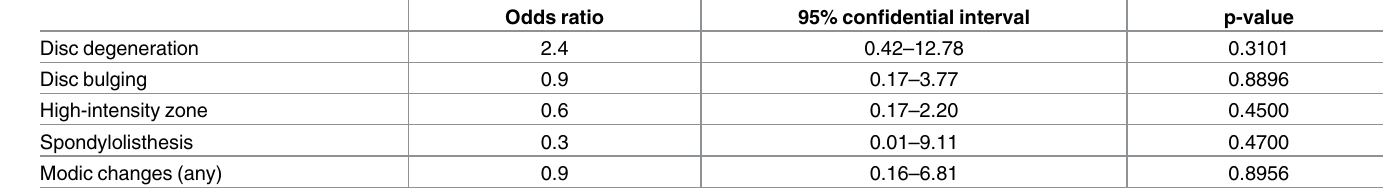
Table 5. Associations between the follow-up magnetic resonance imaging findings and low back pain history during the 10 yearsaccording to univariate